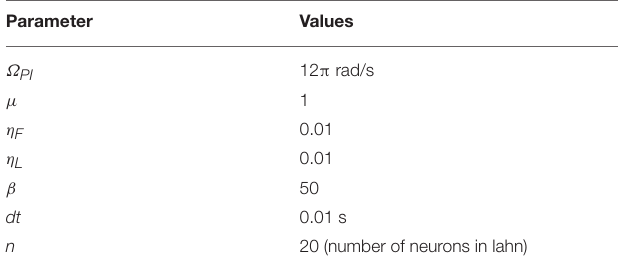
TABLE 1 | Parameter